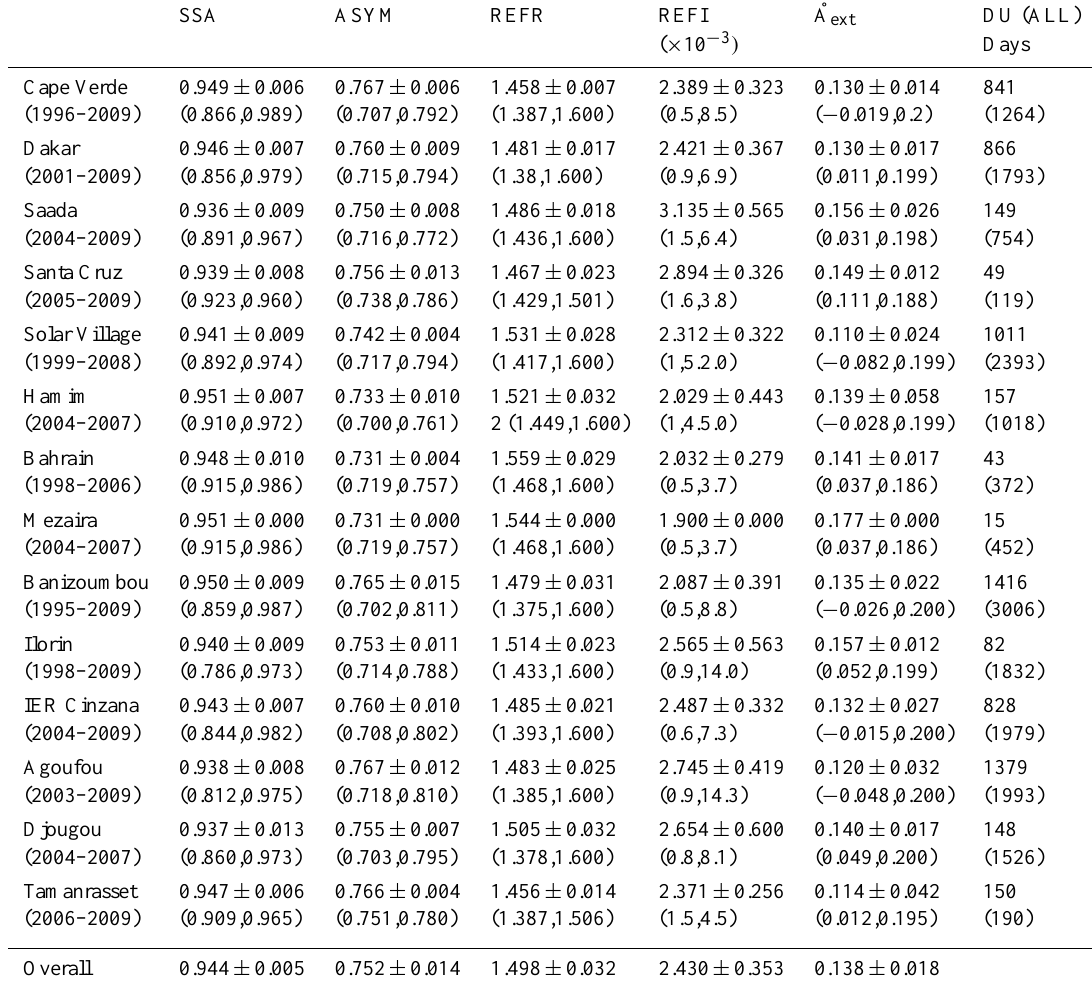
Table 1. Annual mean and standard deviation of single scattering albedo, asymmetry parameter, complex refractive index of DU at 550nm wavelength. ˚Angstr¨om exponent ( ˚A ext ) is at 440–870nm. Sampling period is in the parenthesis of the first column and the number of DU and ALL days during the sampling period is in the last column. Maximum and minimum values are in parenthesis of the optical property related